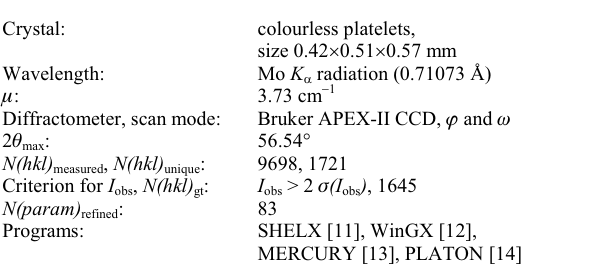
Table 1. Data collection and handling.